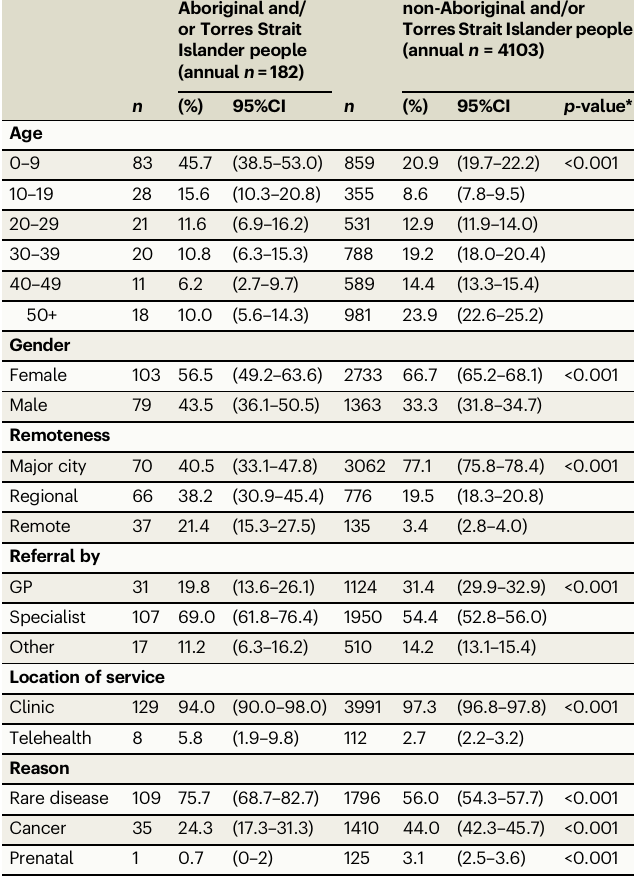
Table 1 | Characteristics of people scheduled an appointment, by Aboriginal and/or Torres Strait Islander